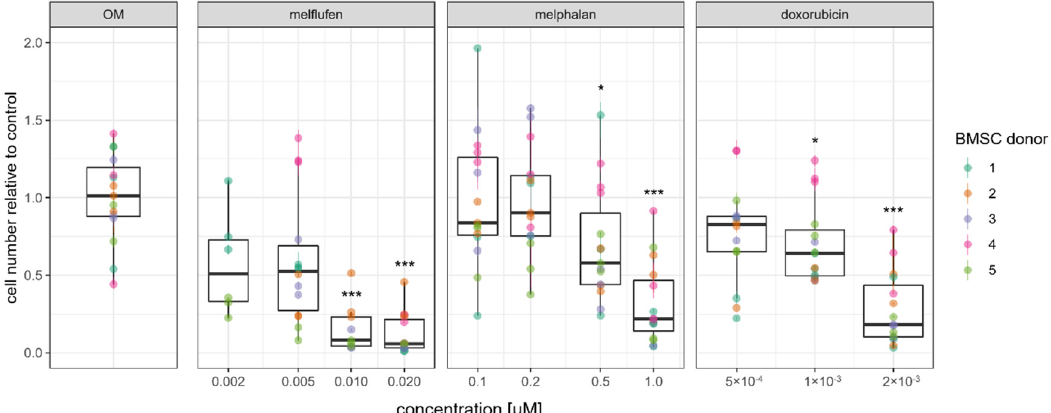
Figure 8. Drug effect on BMSC proliferation in osteogenic differentiation conditions. Relative numbers of BMSCs at 21 days of culture in osteogenic differentiation conditions with melflufen, melphalan, and doxorubicin added at indicated concentrations. Dots represent individual culture wells with a color-coded donor cell line. * denotes p < 0.05 and *** denotes p < 0.001 with Dunn’s test.